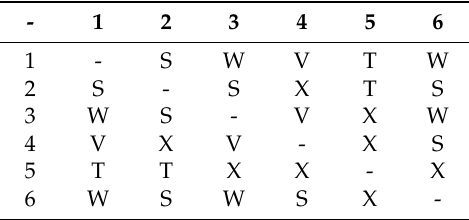
Table 7. The road type from field to